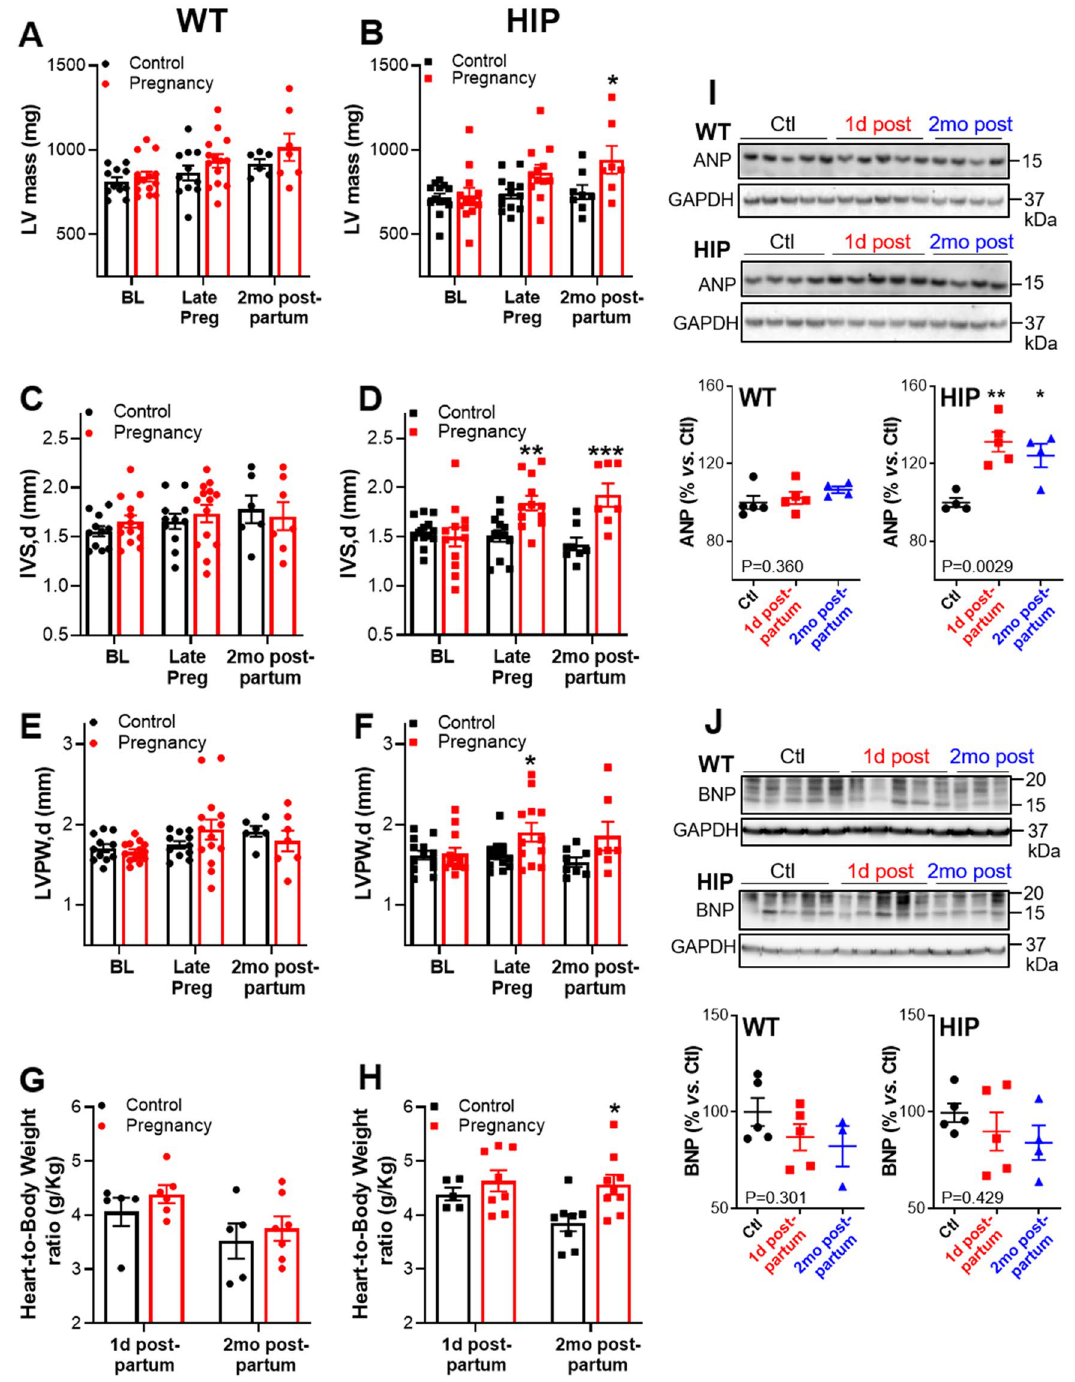
Figure 2. Cardiac hypertrophy in two months postpartum HIP females. ( A – F ) Left ventricular mass ( A,B ), diastolic thickness of the interventricular septum ( C,D ) and diastolic thickness of the left-ventricular posterior wall ( E,F ) in WT ( A,C,E ) and HIP ( B,D,F ) females from control and pregnancy groups at baseline (BL), late pregnancy and 2 months postpartum. ( G,H ) Heart weight-to-body weight ratio of WT ( G ) and HIP ( H ) females at one day and 2 months postpartum. ( I,J ) Expression of ANP ( I ) and BNP ( J ) in hearts from control (Ctl), one day postpartum and 2 months postpartum WT and HIP females. Top panels show representative examples while bottom panels show relative band intensities; the experiment was repeated 4 times. For BNP, the intensity analysis included the bands with molecular weights between 15 and 20 kDa. In panels ( A–H ), statistical significance was determined using Two-way ANOVA with the Bonferroni post-test to compare the pregnancy versus control groups at each timepoint. In panels ( I,J ), data for animals in control (not pregnant) groups sacrificed at the time when pregnancy groups were at 1 day and 2 months postpartum were pooled. For these panels, statistical analysis was performed using One-way ANOVA ( P value is indicated on the graph) with Dunnett’s post-test for multiple